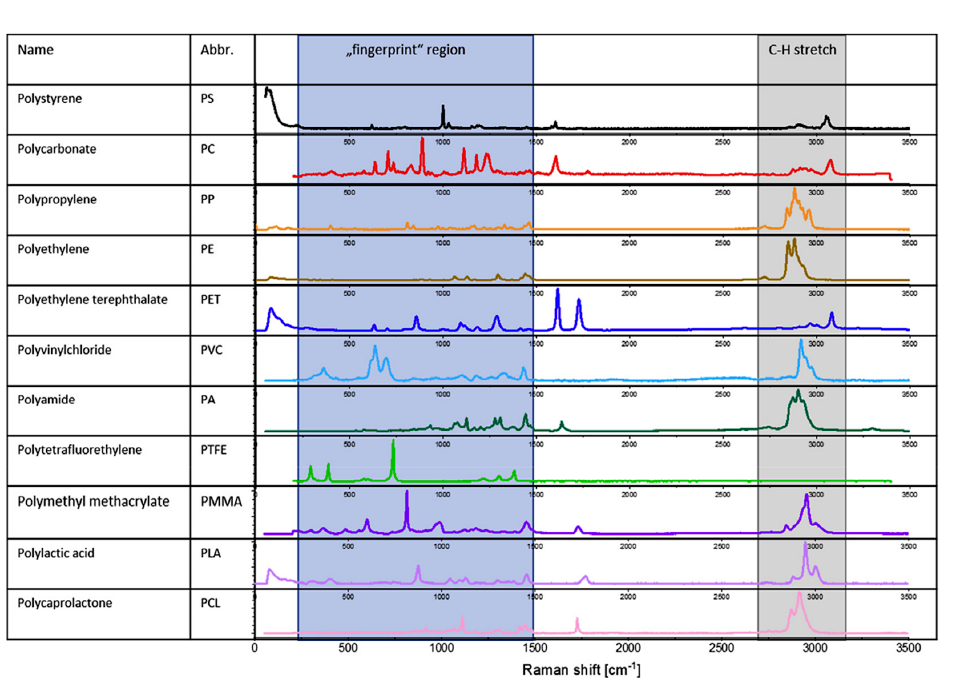
Figure 7. Raman spectra of a variety of synthetic polymers common to microplastics. Figure reproduced from Ref. [68] with permission of publisher.